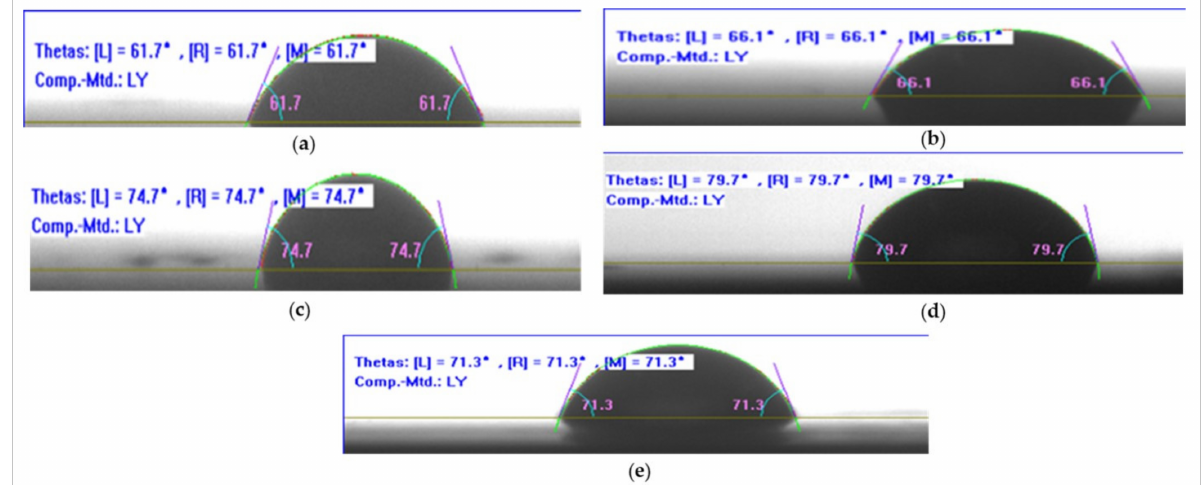
Figure 11. The contact angle images of ( a ) neat epoxy and ( b ) 0.5 wt.% of CNTs ( c ) 1 wt.% of CNTs ( d ) 1.5 wt.% ( e ) 2 wt.% of CNTs.